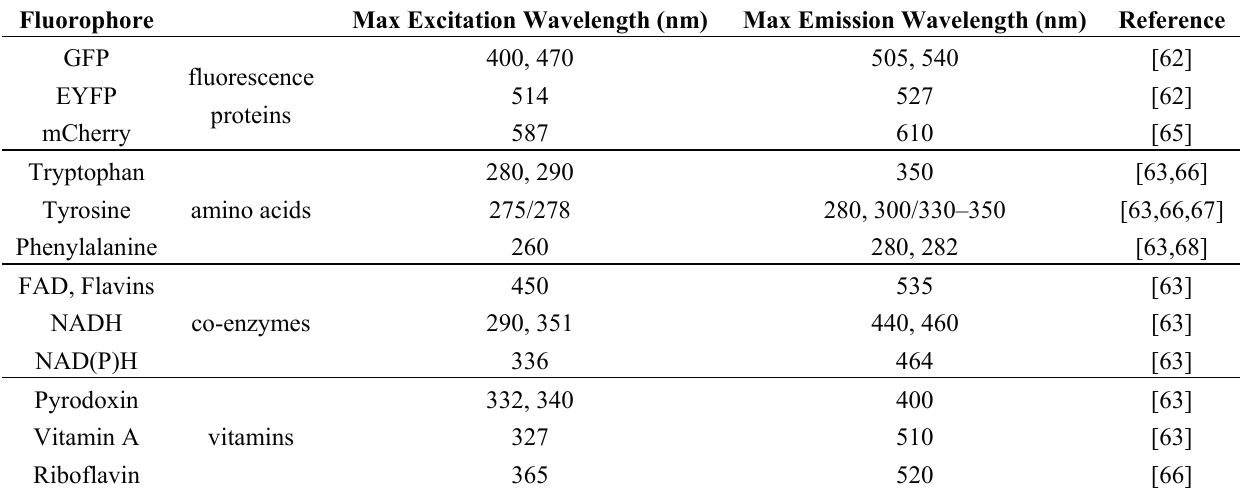
Table 2. Excitation and emission wavelengths for some fluorophores used in biotechnology. Fluorophore